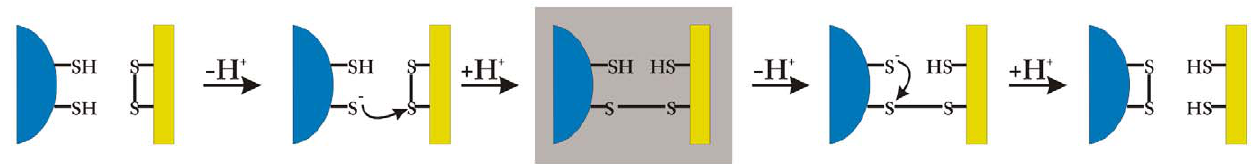
Figure 2. Basic mechanism of disulfide reduction catalyzed by a thioredoxin-fold domain. (Thioredoxin domain shown in blue). The mixed disulfide intermediate has been highlighted in gray. Note the resolution of this intermediate through attack of the thiolate form of the C-